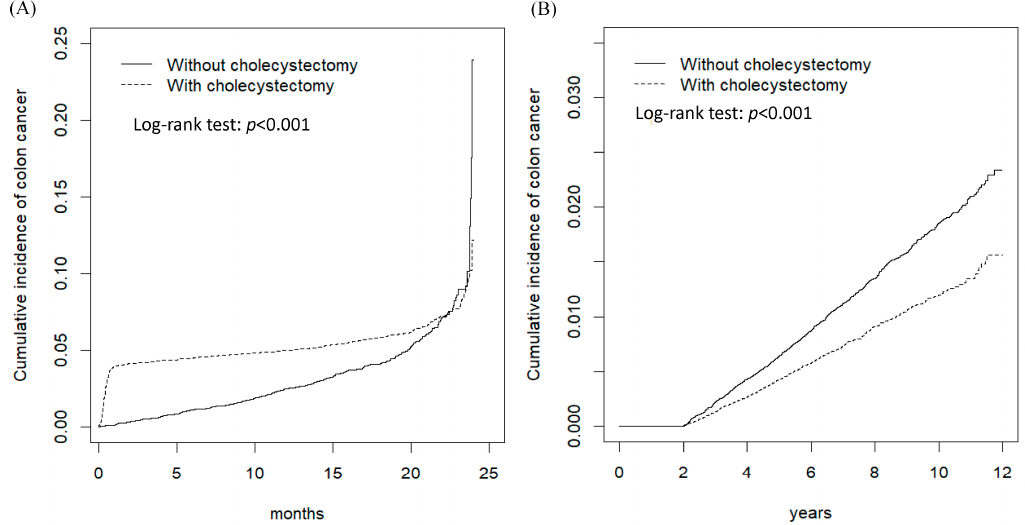
Figure 2. The cumulative incidence comparison of colon cancer for gallbladder stones patients with (dashed line) or without (solid line) cholecystectomy for the follow-up period ≤ 6 months ( A ) and for the follow-up period > 6 months ( B ).